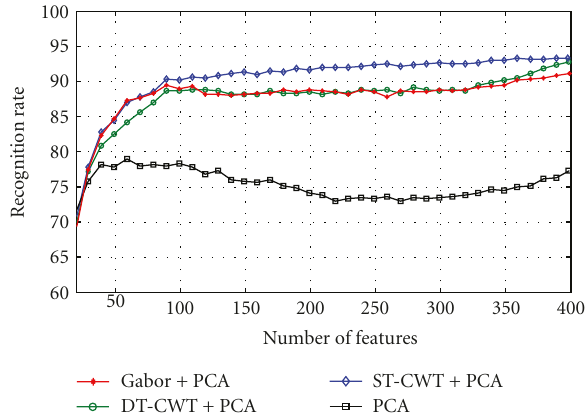
Figure 14: Face recognition performance of the FERET database using PCA, Gabor+PCA, DT-CWT+PCA, and STCWT+PCA for the δ L 1 ( L 1 ) similarity measure. The recognition rate means the accuracy rate for the top response being correct.